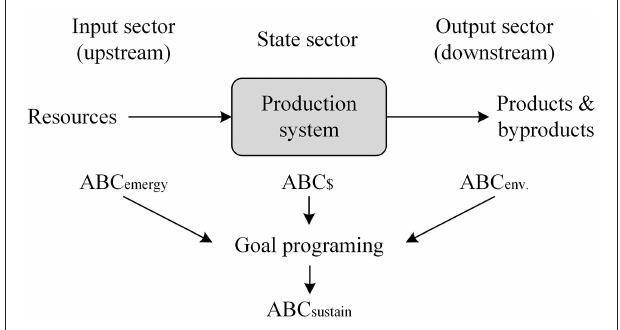
FIGURE 2 | Production systems as open systems showing the sectors in which the three different ABC approaches are focused on.